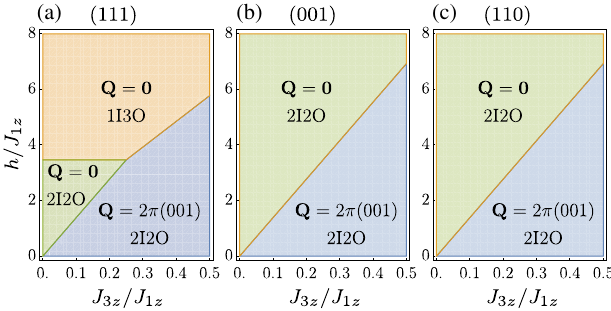
FIG. 5. Phase diagram of the Pr local moments under the external magnetic fields along different directions. Here, “ 1I3O ” refers to “ 1-in – 3-out ” spin